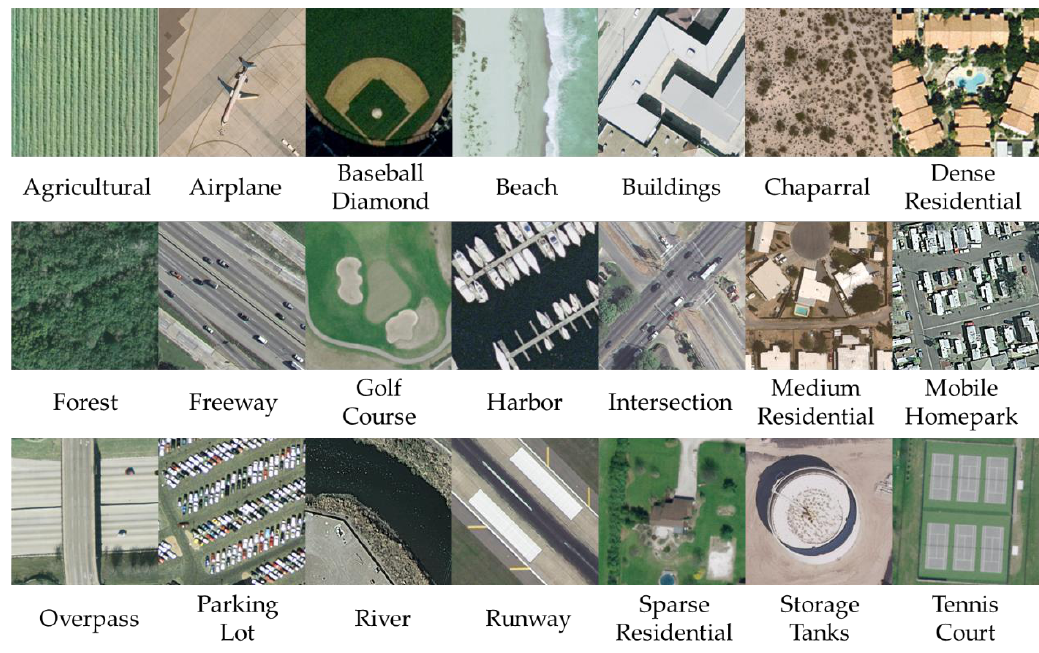
Figure 3. The representative images of UCMerced for every type [37].